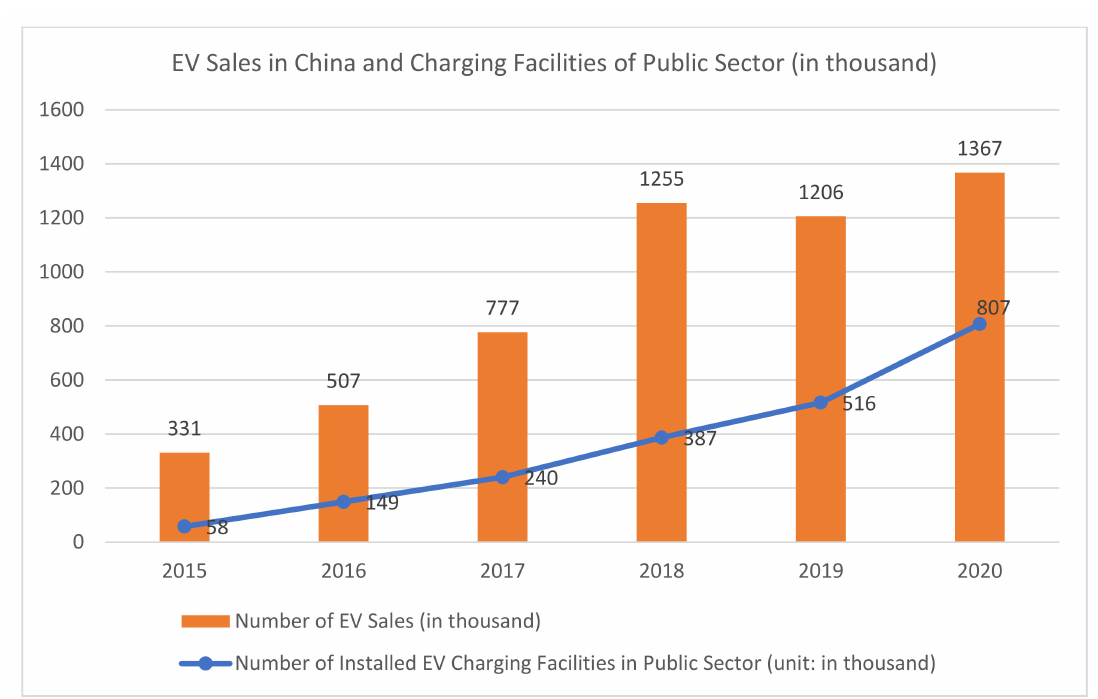
Figure 1. EV Sales in China and Charging Facilities of Public Sector (in thousand). Source: